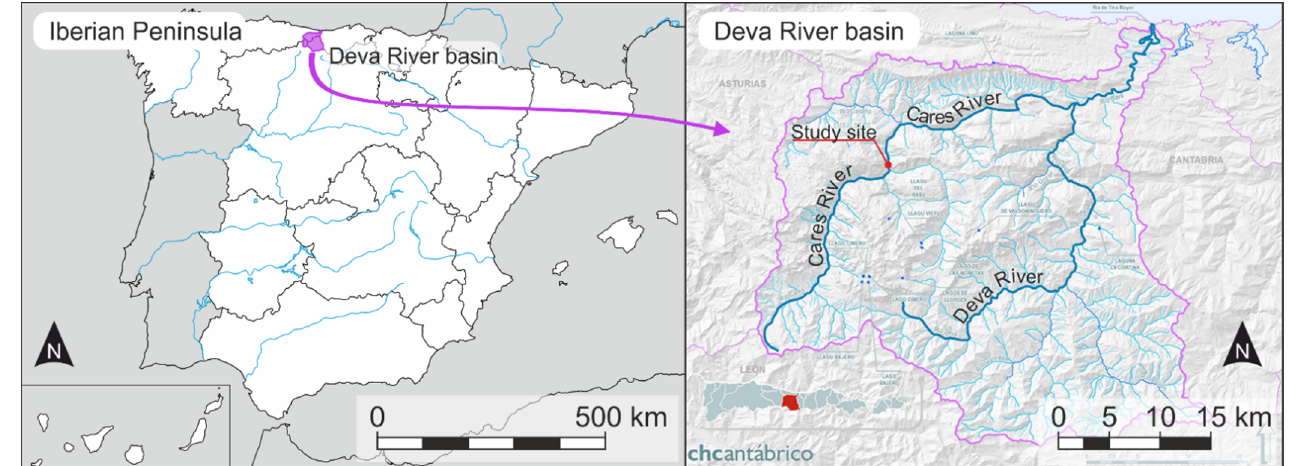
Figure 1. Location of the study site (Iberian Peninsula, Asturias, Cares River).